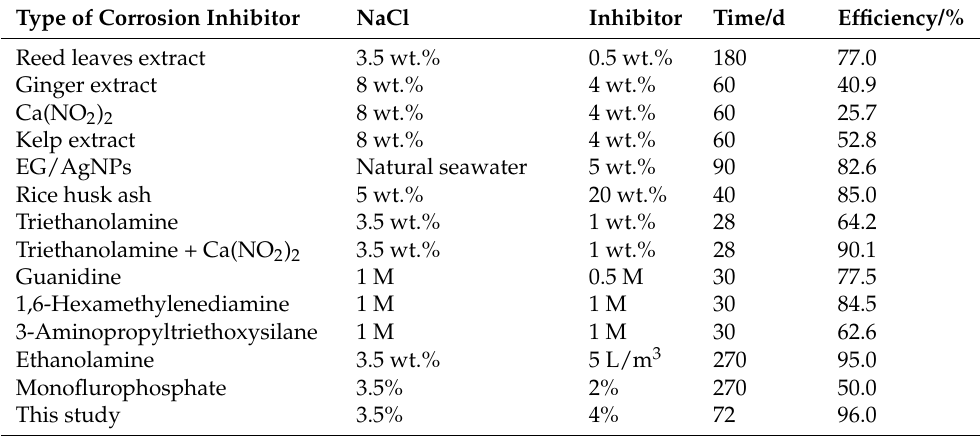
Table 9. Comparison of the inhibition efficiency of the hydrophobic functional organic corrosion inhibitor in this study and corrosion inhibitors in the reported studies